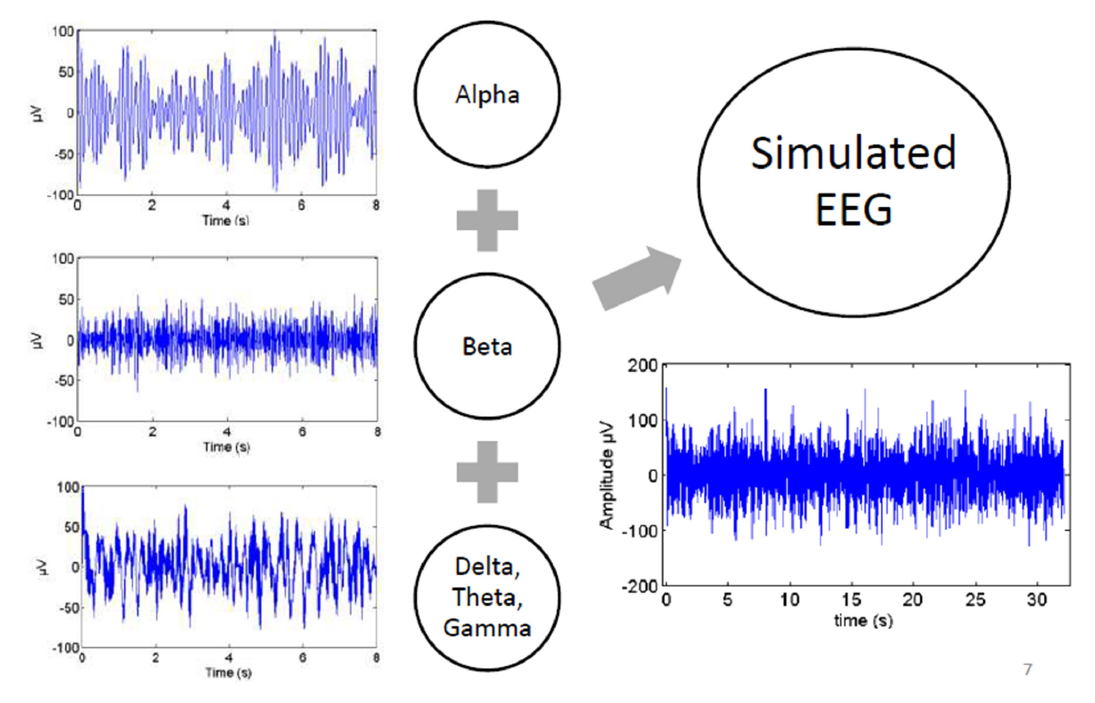
Figure 10. Method used to generate an artificial EEG for the simulation study.